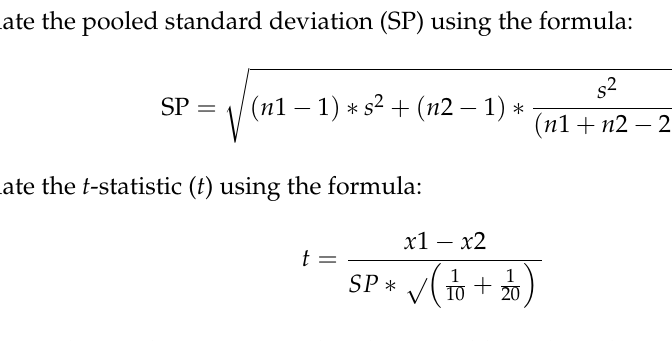
Table 5. List of quiz questions proposed for quantifying students’ knowledge acquisition. No.Crt. Question Type What is a Petri net? Single choice What is a graph? Single choice What is a workflow management system? Single choice Which from the workflows below are well defined? Multiple choice What is missing from the Petri net from the figure? Multiple choice Which from the workflows below are well defined? Multiple